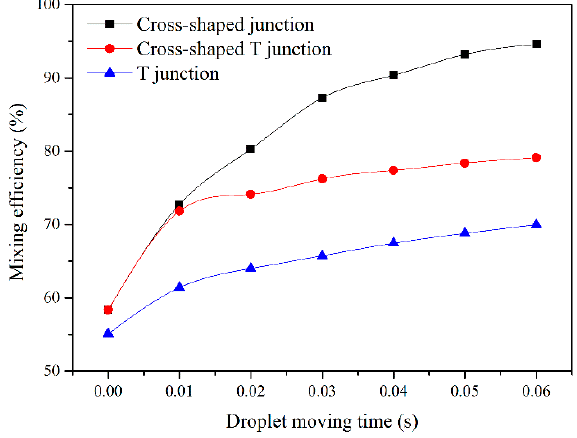
Figure 11. Mixing efficiency in different droplet moving time. u total = 50 mm/s, ε d = 0.5.